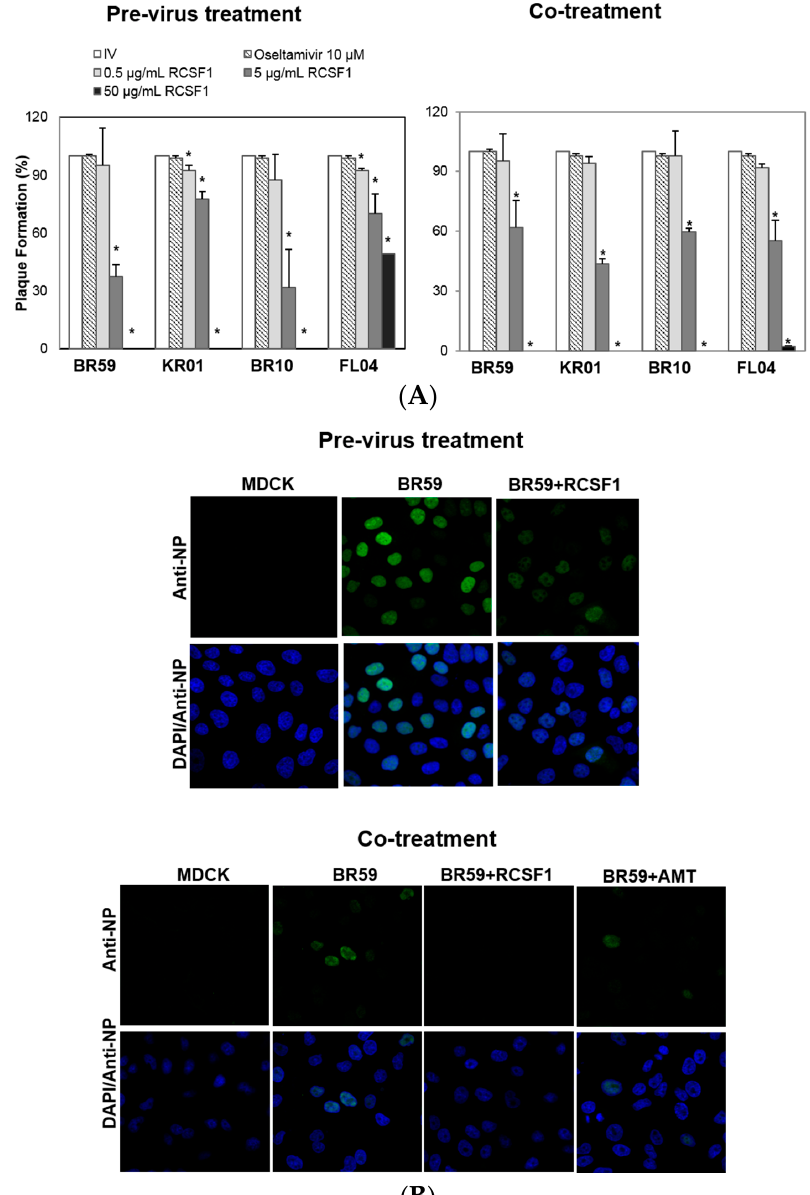
Figure 1. Antiviral activities of Rubus coreanus seed fraction 1 (RCSF1) against BR59, KR01, BR10 and FL04. In time-of-addition assays: ( A ) pre-virus treatment: each virus was mixed with RCSF1 for 1 h prior to viral infection; co-treatment: cells were infected with virus and RCSF1 simultaneously for 1 h at 37 °C. After infection, the cells were washed and overlaid with agarose at 37 °C for 72 h. Non-treated influenza virus (IV) and oseltamivir (10 μ M) were used as negative and positive controls, respectively. All measurements were performed in triplicate. * p < 0.05. For confocal microscopy, BR59 was infected into MDCK cells at an MOI 2. Treatment of RCSF1 (50 μ g/mL) was analyzed in ( B ) the pre-virus and co-treatment. Antiviral effect was analyzed by detection of viral NP (green) and DAPI (blue) using a confocal laser scanning microscope. Amantadine (AMT) was used as the positive control.